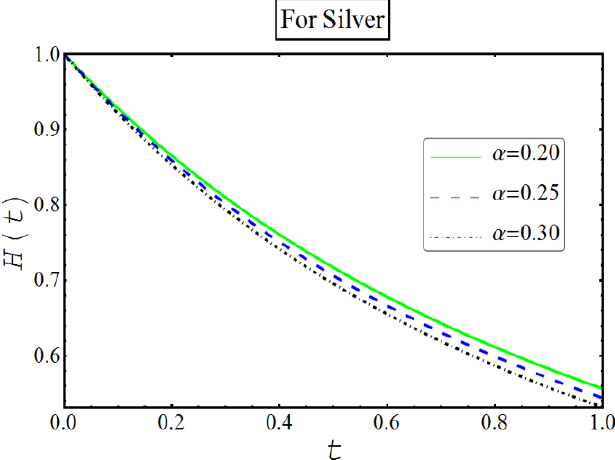
Figure 4. Behaviour of film thickness for thermocapillary parameter for gold particles.